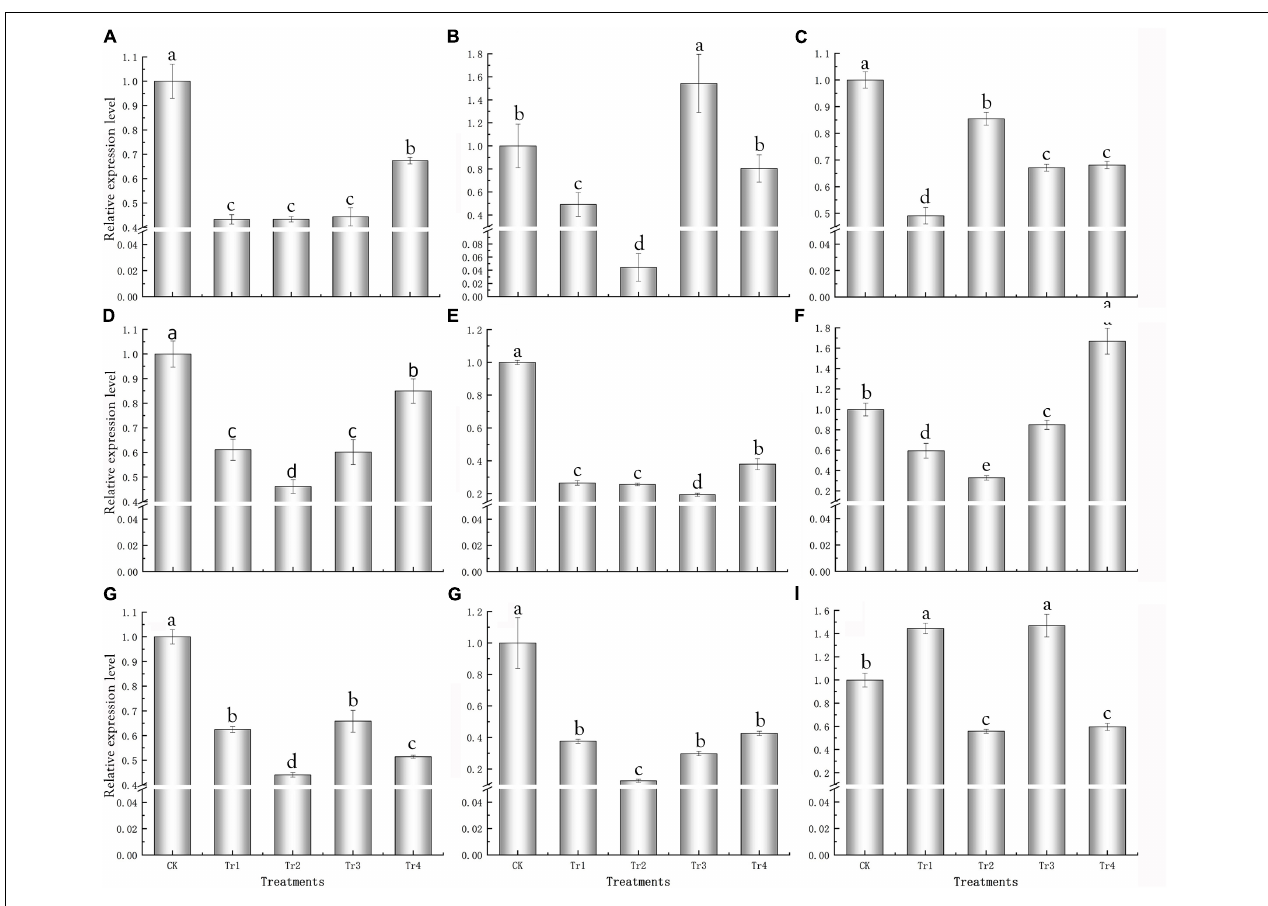
FIGURE 5 | qRT-PCR analysis of key genes responsive to saline–alkali stress in K. pentacarpos seedlings. (A) F01_transcript_53932 ( KpCPSF3 ), (B) F01_transcript_13312 ( KpLARP1C ), (C) F01_transcript_3631 ( KpAGO4 ), (D) F01_transcript_7879 ( KpVPS35A ), (E) F01_transcript_59507 ( KpPUB33 ), (F) F01_transcript_25894 ( KpHIR1 ), and (G–I) F01_transcript_95488, F01_transcript_9571, and F01_transcript_4187 (their function is